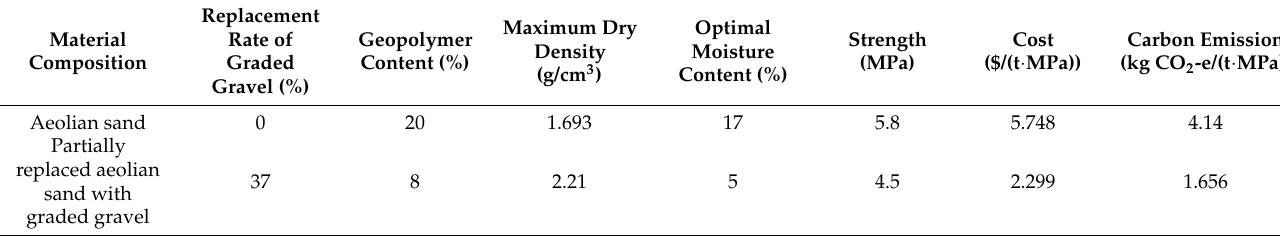
Table 5. Performance index of pavement base material.